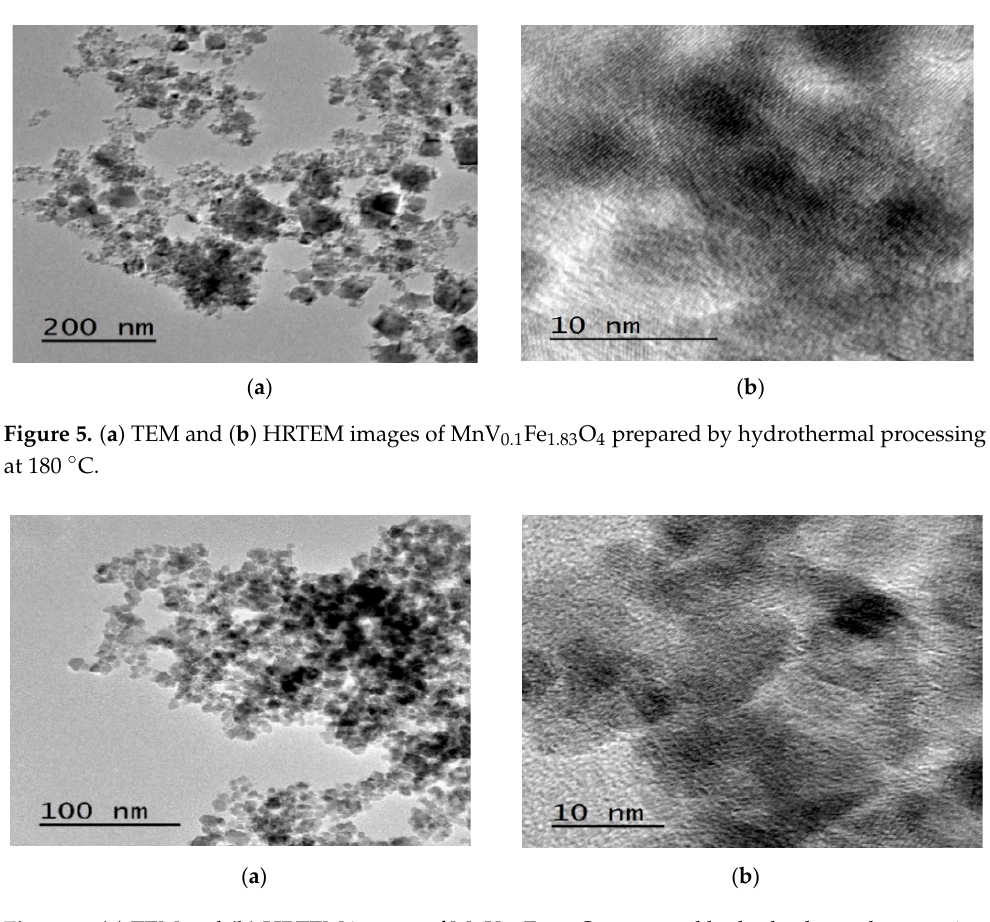
Figure 6. ( a ) TEM and ( b ) HRTEM images of MnV 0.2 Fe 1.67 O 4 prepared by hydrothermal processing at 180 °C.